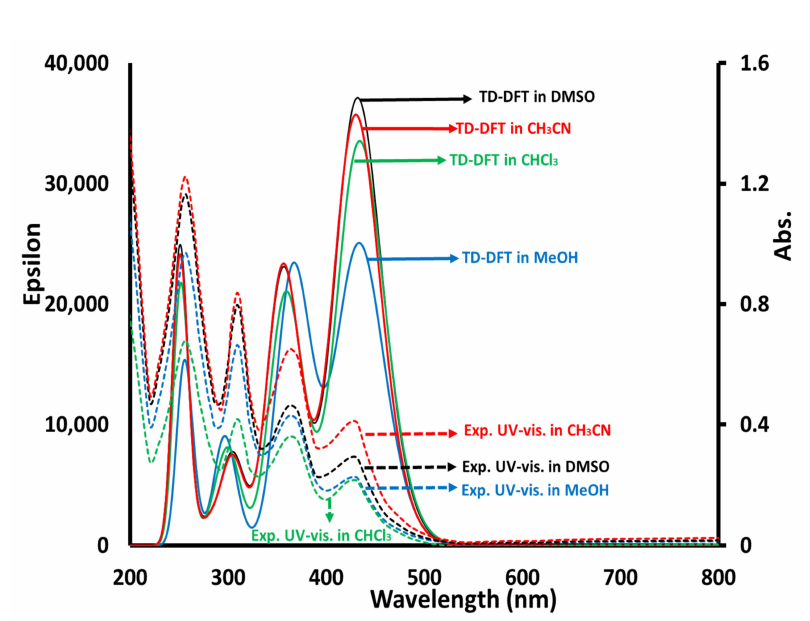
Figure 9. Experimental and TD-DFT solvents